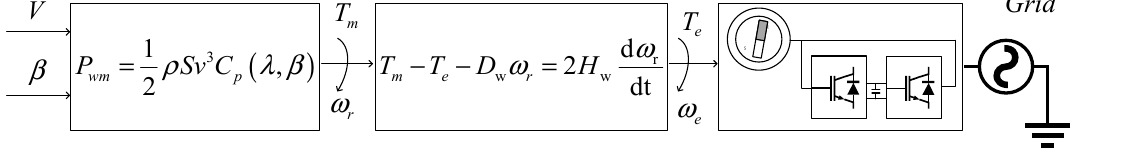
Figure 5. Model structure of wind turbine.